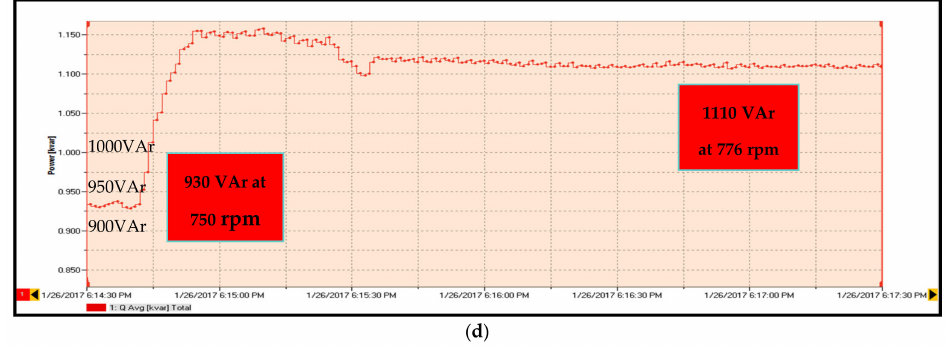
Figure 18. Grid side experimental waveforms for load test (1): ( a ) speed equivalent voltage (V), ( b ) phase A grid voltage and current, ( c ) grid active power (W) [ Y-axis: 50 W / div, X-axis: 15 s / div ], and ( d ) grid reactive power (VAr) [ Y-axis: 25 VAr / div, X-axis: 15 s / div ].